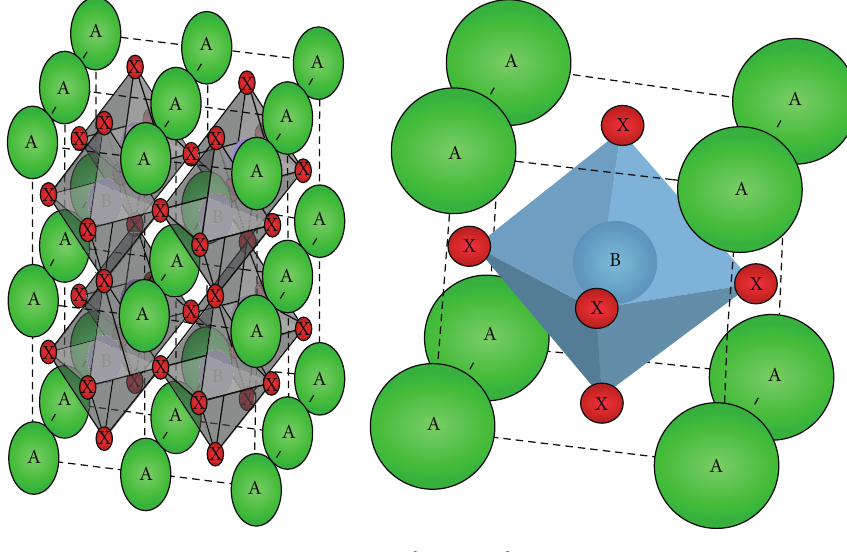
Figure 1: Perovskite crystal structure.